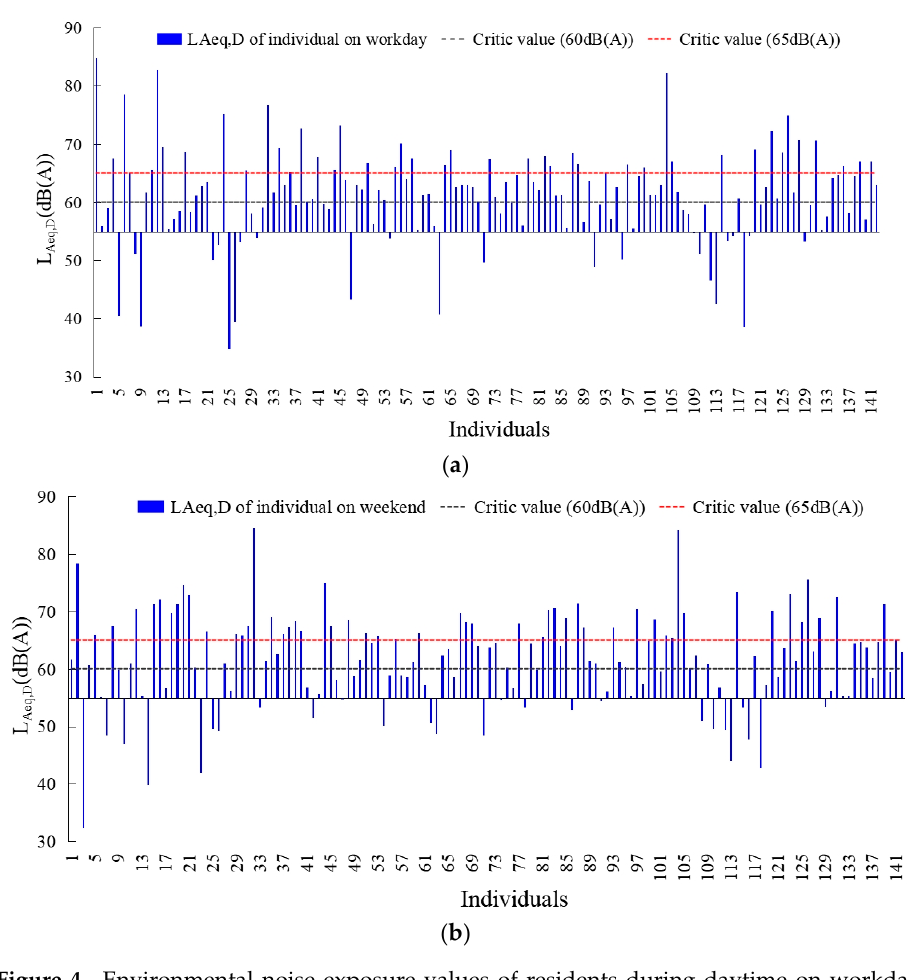
Figure 4. Environmental noise exposure values of residents during daytime on workdays and weekends. ( a ) Workday; ( b ) weekend.